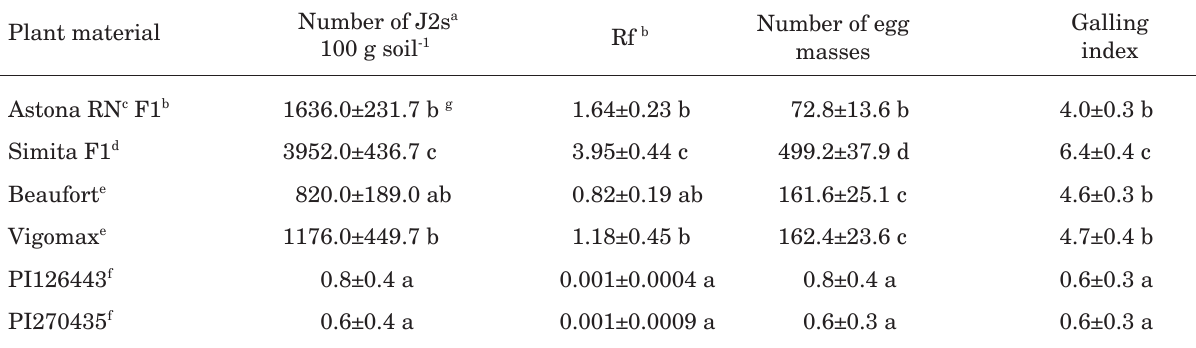
Table 4. Response of Meloidogyne incognita race 2 at 32°C soil temperature to tomato rootstocks, resistant and susceptible cultivars, and heat stable